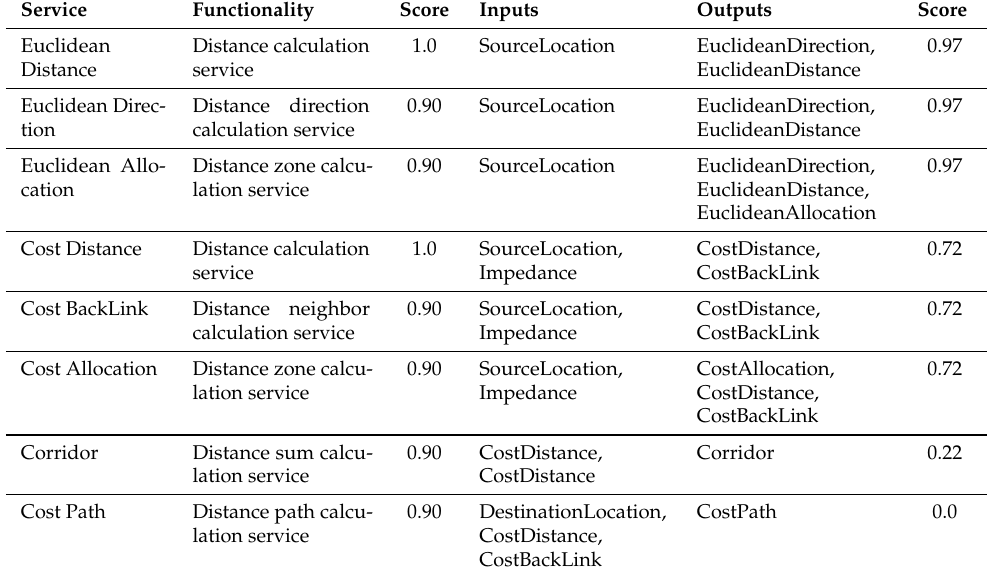
Table 5. Results of request R1 .